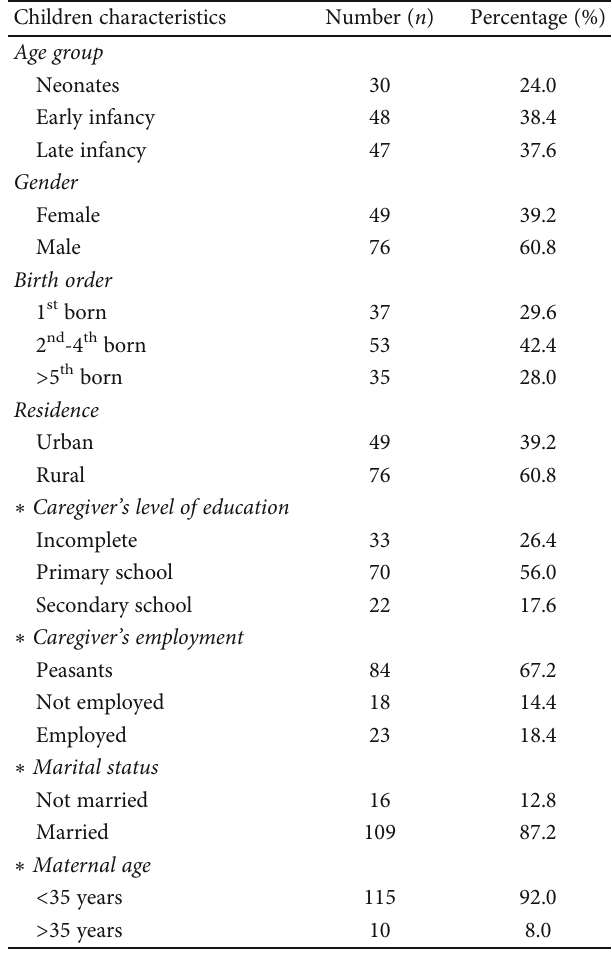
Table 1: Sociodemographic characteristics and other relevant characteristics among infants and their